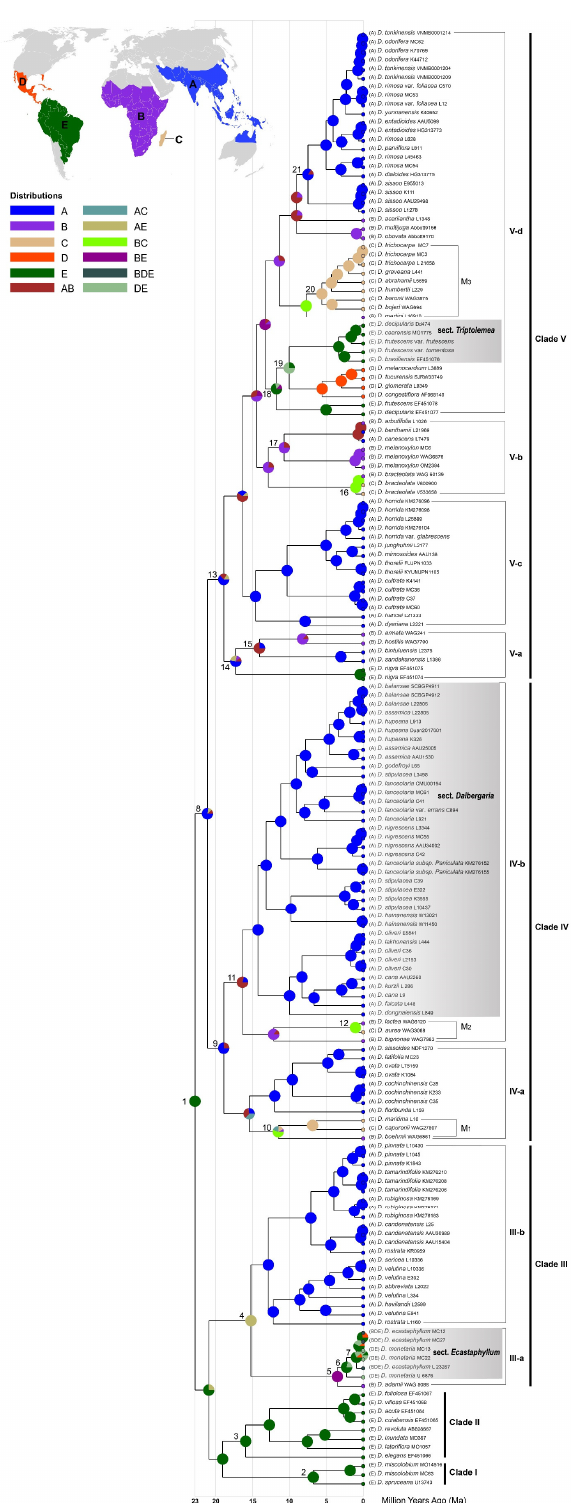
Figure 3. Ancestral area reconstructions under the dispersal–extinction cladogenesis (DEC) model in the BioGeoBEARS package as implemented in RASP; the relative probabilities of alternative ancestral areas are shown by pie charts at each node. Nodes of interests are marked 1–21. Area abbreviations are as follows: A—Australasia; B—Africa; C—Madagascar; D—Central America (including Florida and the Caribbean); E—South America. M1, M2, and M3 represent the Madagascar